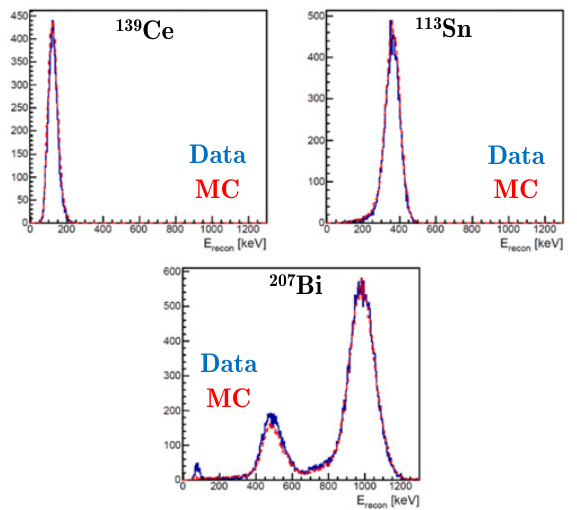
Figure 4. Comparison of simulated (red) and data (blue) spectra from calibration runs with 139 Ce, 113 Sn, and 207 Bi calibration sources.